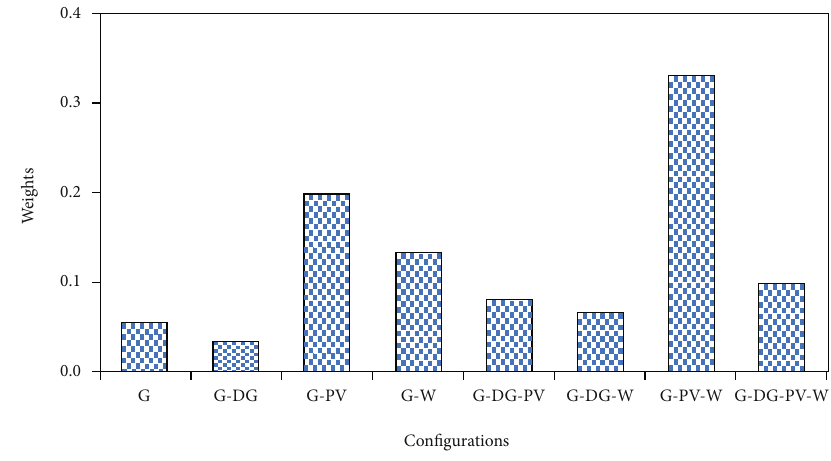
Figure 9: Weights of di ff erent hybrid con fi guration using Table 7: Comparison of emission parameters for di ff erent energy system con fi gurations. Emissions (kg/yr.) Con fi guration